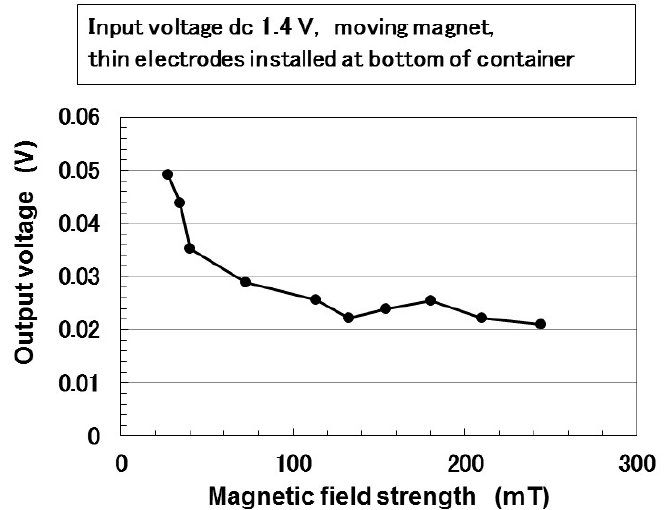
Figure 14. Relation between input and output voltage at a position of the magnet from the bottom of the container for a moving magnet and with electrodes installed at the bottom of the container.